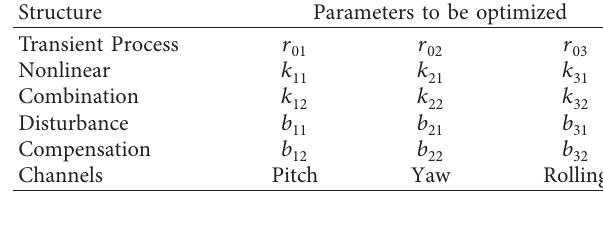
Table 2: ADRC parameters to be optimized. Structure